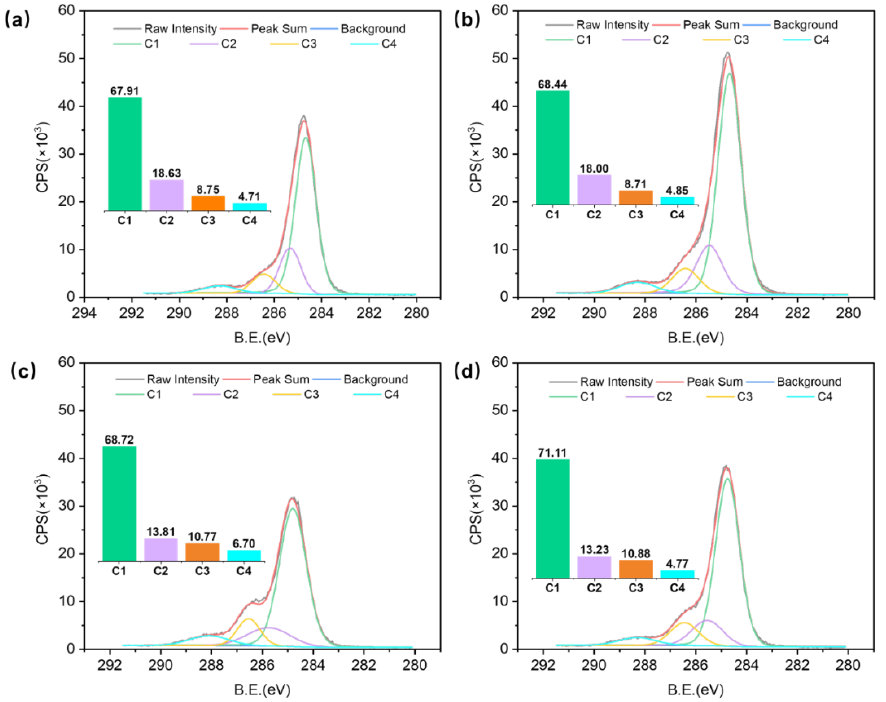
Figure 6. Effect of TPM temperature on the C1s’ peak components in the following samples: ( a ) 160 °C; ( b )170 °C; ( c ) 180 °C; and ( d ) 190 °C. The bars with different colors inside of the figure represent the values of C1, C2, C3, and C4, respectively.